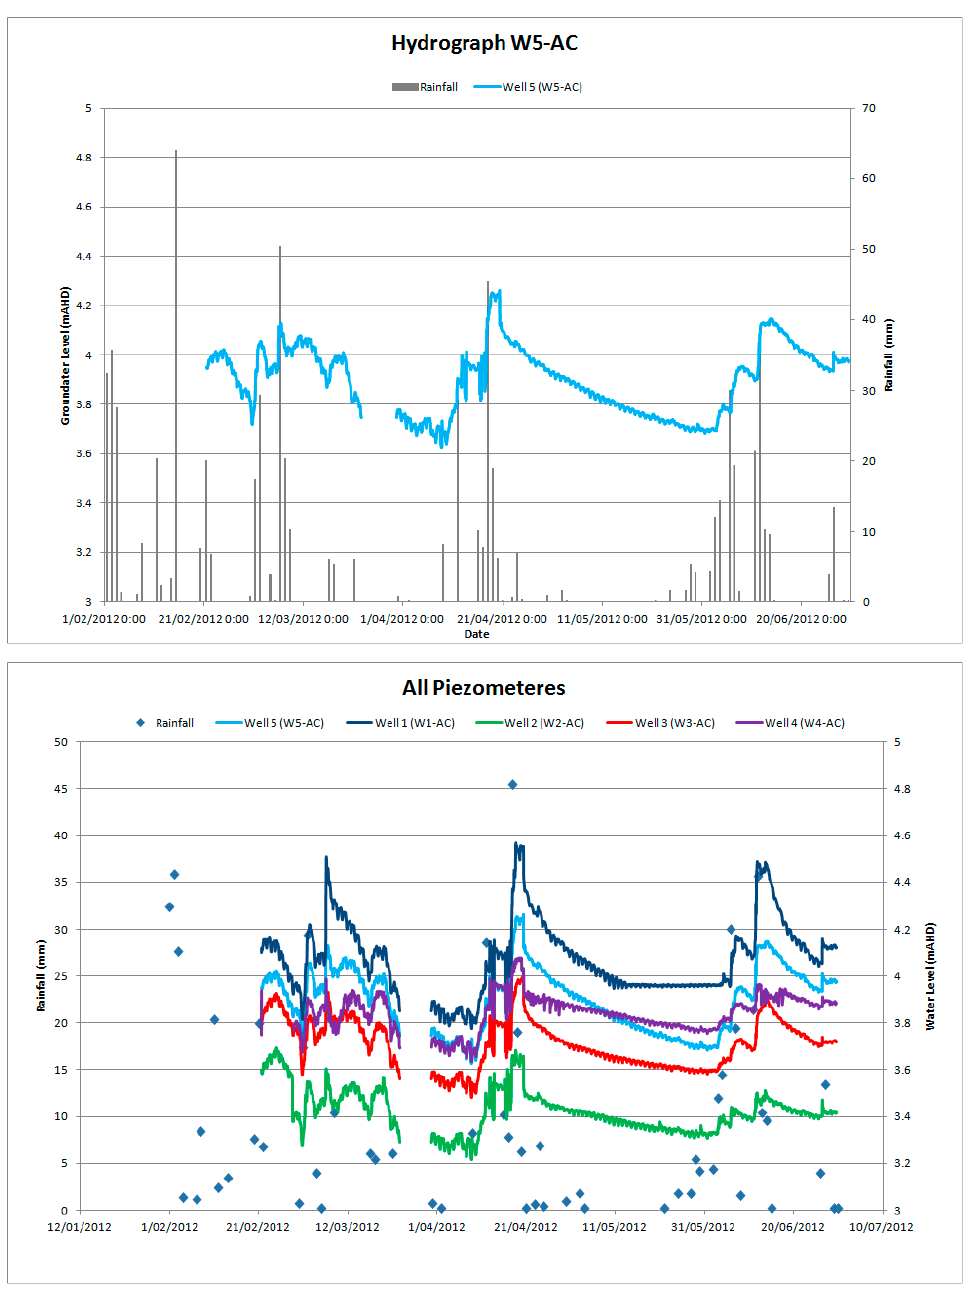
Figure 4. Groundwater level and rainfall versus time (piezometers).